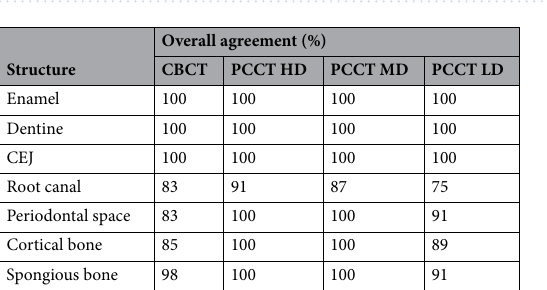
Figure 2. Example of an apical osteolysis of tooth 24 in all scan protocols; AO apical osteolysis. (C = 1535 HU, W = 8504 HU).